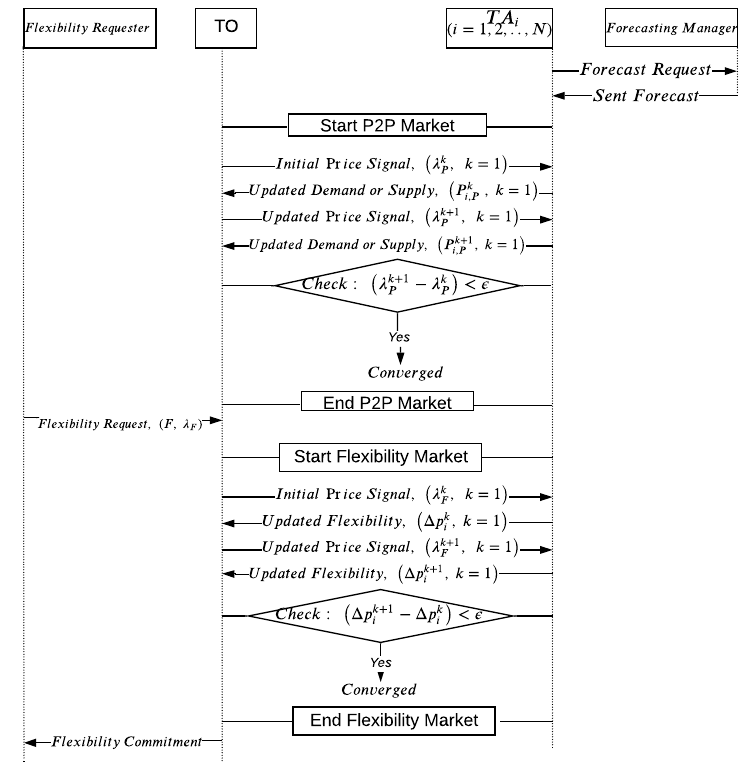
Figure 3. Sequence of communication flow of the Peer-toPeer (P2P) and flexibility market in the Monash